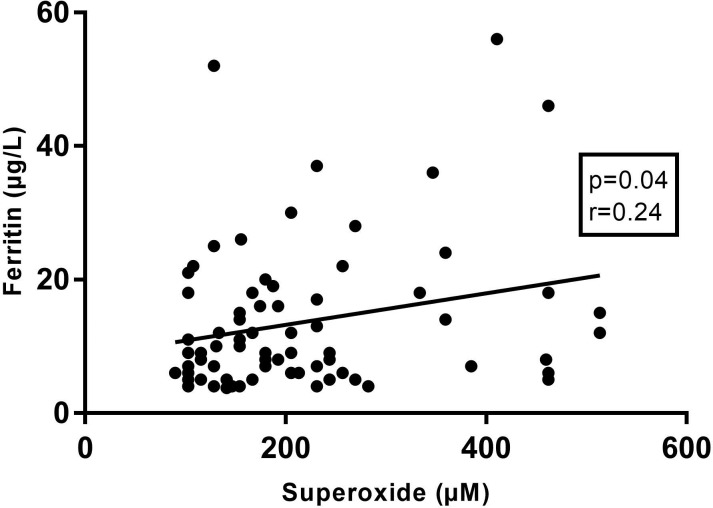
Correlation of superoxide concentrations with ferritin levels at 25 weeks of pregnancy.(r: pearson correlation coefficient).